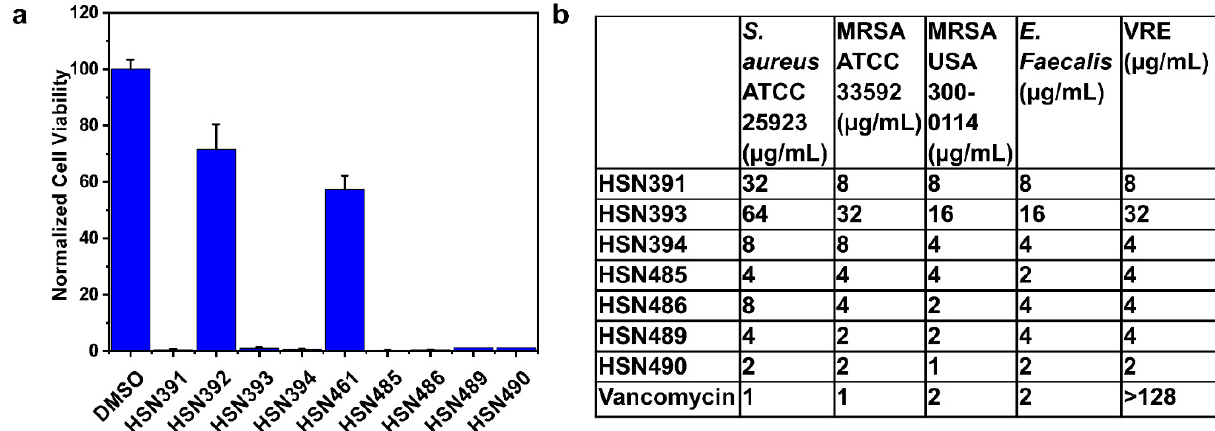
Figure 2. Structures of alkynyl isoquinolines with antibacterial activity.